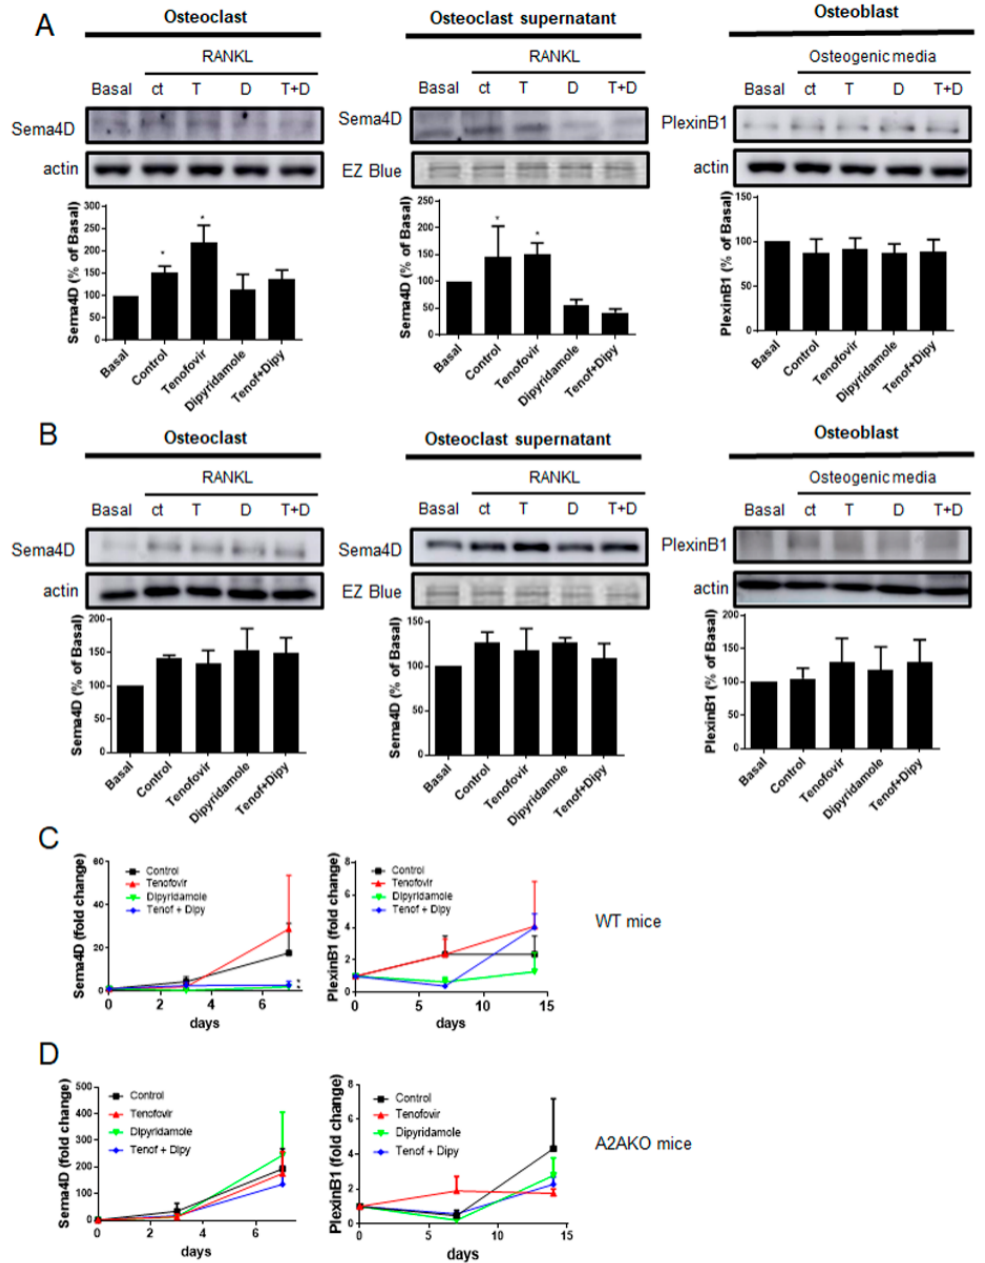
Figure 3. Sema4D expression and secretion are increased in the presence of tenofovir, and they are reverted with dipyridamole in an A2A-dependent manner. ( A ) Sema4D protein expression and secretion were studied in WT osteoclast precursors in the presence of tenofovir at 1 µ M alone or with dipyridamole at 1 µ M for 24 h. PlexinB1 protein expression was studied in WT osteoblast precursors in the presence of tenofovir at 1 µ M alone or with dipyridamole at 1 µ M for 24 h. To normalize for protein loading, the membranes were reprobed with actin or EZ Blue (supernatant). ( B ) Sema4D protein expression and secretion were studied in A2AKO osteoclast precursors in the presence of tenofovir at 1 µ M alone or with dipyridamole at 1 µ M for 24 h. PlexinB1 protein expression was studied in A2AKO osteoblast precursors in the presence of tenofovir at 1 µ M alone or with dipyridamole at 1 µ M for 24 h. To normalize for protein loading, the membranes were reprobed with actin or EZ Blue (supernatant). ( C ) Changes in Sema4D and PlexinB1 mRNA during osteoclast and osteoblast differentiation process respectively in WT mice in the presence of tenofovir 1 µ M alone or with dipyridamole 1 µ M. ( D ) Changes in Sema4D and PlexinB1 mRNA during osteoclast and osteoblast differentiation processes, respectively, in A2AKO mice in the presence of tenofovir 1 µ M alone or with dipyridamole 1 µ M. * p < 0.05 ANOVA.